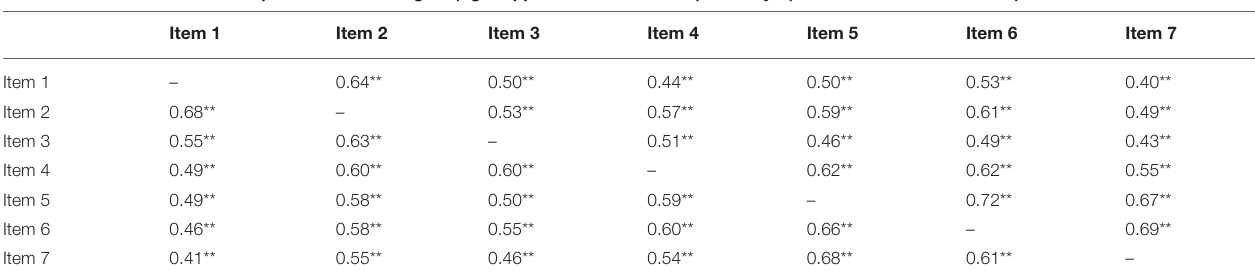
TABLE 3 | Correlation coefficients for gender